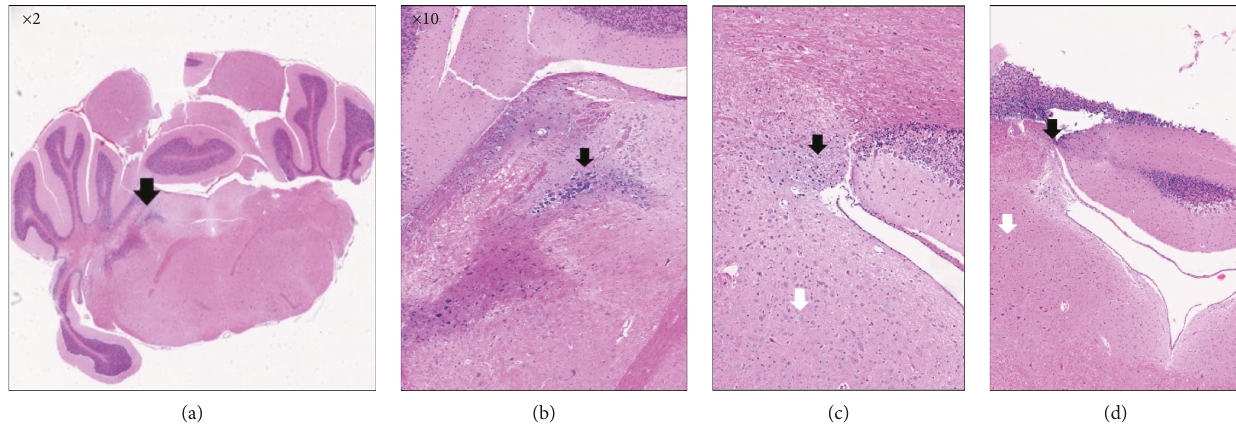
Figure 3: The image in (a) is an image from the mouse brain atlas depicted with black arrows in the LC region from a sagittal view. Areas of interest: microscopic images of coronal views of the neurons of the LC (a, b) and the Purkinje/molecular layer neurons around the LC (c,